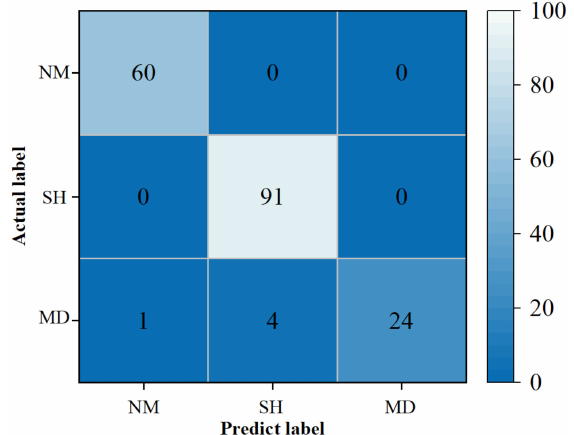
Figure 7. Confusion matrix of test set based on MRSA-SVM. NM, SH and MD represented normal jujube, starch-head fruit and mildewed fruit,